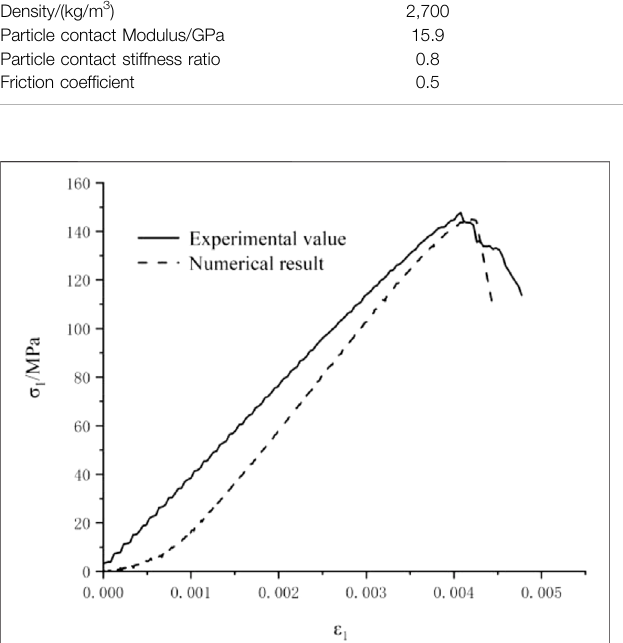
FIGURE 3 | Uniaxial stress-strain curve test.